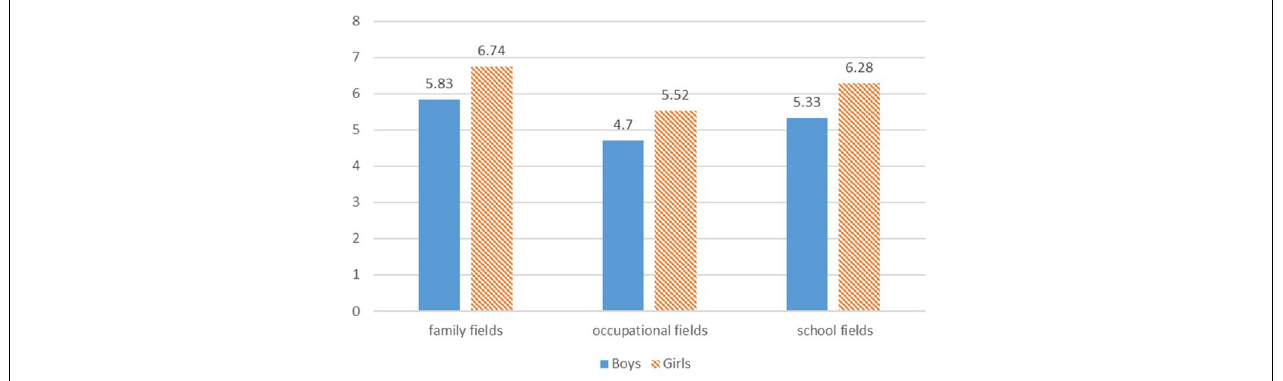
FIGURE 1 | Gender differences of gender equality awareness in all fields with school-age children.